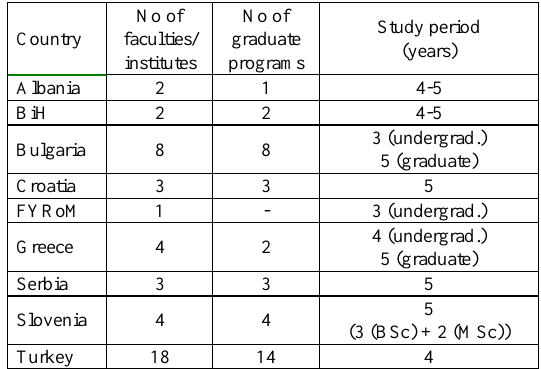
Table 2. Dedicated undergraduate and graduate programs relating to